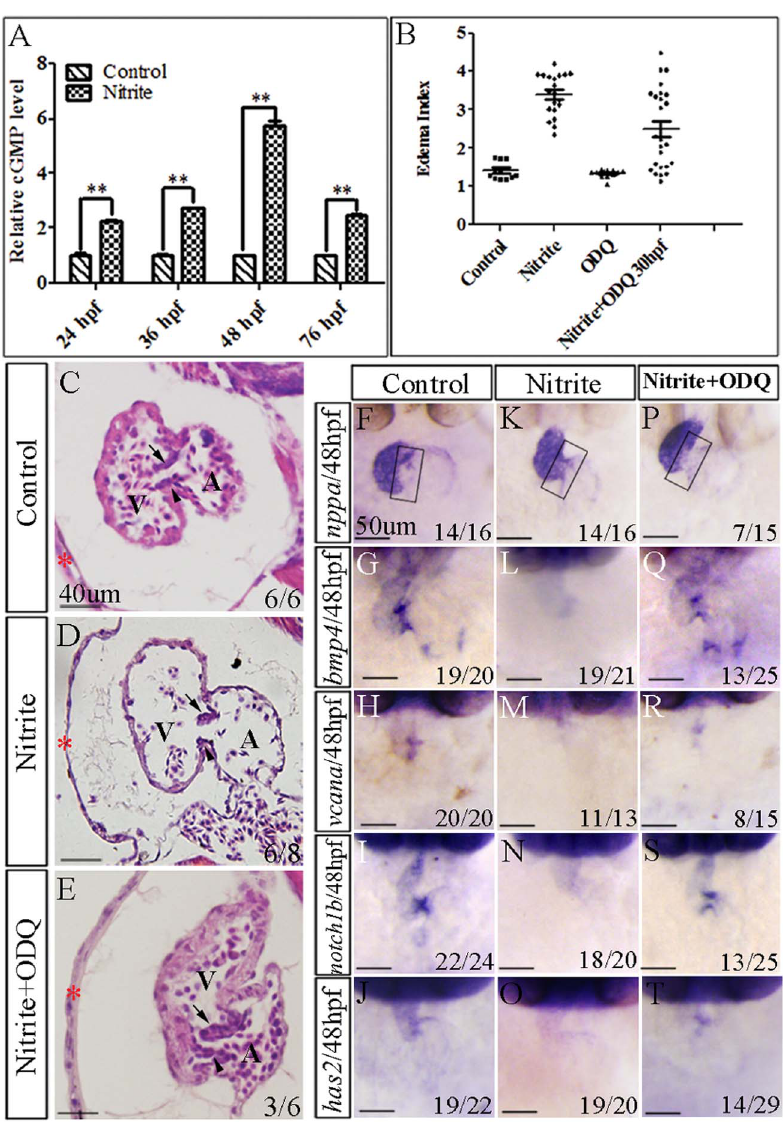
Figure 4. Inhibiting NO signaling in nitrite-exposed embryos partially rescued defective development of cardiac valve in zebrafish embryos. (A) The cGMP level was dramatically increased in the nitrite-exposed embryos at 24, 36, 48 and 76 hpf, respectively. **: P , 0.01. The values of cGMP amount in all the control embryos were normalized to 1.0, respectively. The value of cGMP amount in the nitrite-exposed embryos was the fold of the control embryos at the same developmental stage. (B) A scatter plot showing the increased EIs in the nitrite-exposed embryos were significantly reduced by microinjecting ODQ (sGC inhibitor) into nitrite-exposed embryos. Different treatments of embryos were shown in X-axis. EI (shown in Y-axis) of each embryos was shown in the plot. Average 6 standard errors of EIs were shown in lines. (C–E) Defective histological structures of heart caused by excessive nitrite were partially rescued by microinjection of ODQ into nitrite-exposed embryos. Embryos were observed at 108 hpf. Compared to control embryos with normal pericardial membrane, myocardium and both superior and inferior valve leaflets (C), 6/8 embryos exposed to the nitrite showed thinner myocardium and defective formation of either superior or inferior leaflets (D). ODQ microinjection resulted in 3/6 of the embryos developed both superior and inferior leaflets (E). (F–T) Microinjection of ODQ partially rescued the diminished expressions of valve progenitor makers in zebrafish embryos at 48 hpf. nppa is not expressed in the AVC (rectangular box) of control embryos (F) but was ectopically expressed in the AVC of nitrite-exposed embryos (K). Microinjection of ODQ into nitrite-exposed embryos prevented 7 of 15 embryos from expressing nppa in AVC (P). Compared to control embryos, nitrite exposure significantly decreased or abolished expressions of bmp4 (G, L), vcana (H, M), notch1b (I, N) and has2 (J, O) in AVC. However, microinjection of ODQ into nitrite-exposed embryos resumed expressions of bmp4 (Q), vcana (R), notch1b (S) and has2 (T) in about half embryos. Red star (*): pericardial membrane; Black arrow: position of superior valve leaflet; Black arrowhead: position of inferior valve leaflet; A: atria; V: ventricle. doi:10.1371/journal.pone.0092728.g004 revealed the looping defect first occurred in the embryos at 43 hpf by excessive nitrite. Consistently, nppa (natriuretic peptide precur- sor type A), normally expressed in myocardial cells of ventricle and (Figure 3K–L). Because the region between atria and ventricle is the place where AVC gives rise to AV valves, the abnormal atria and absent from the AVC [20,21] (Figure 3O), was looping suggested the progenitors of AV valves could be affected ectopically expressed in the region between atria and ventricle